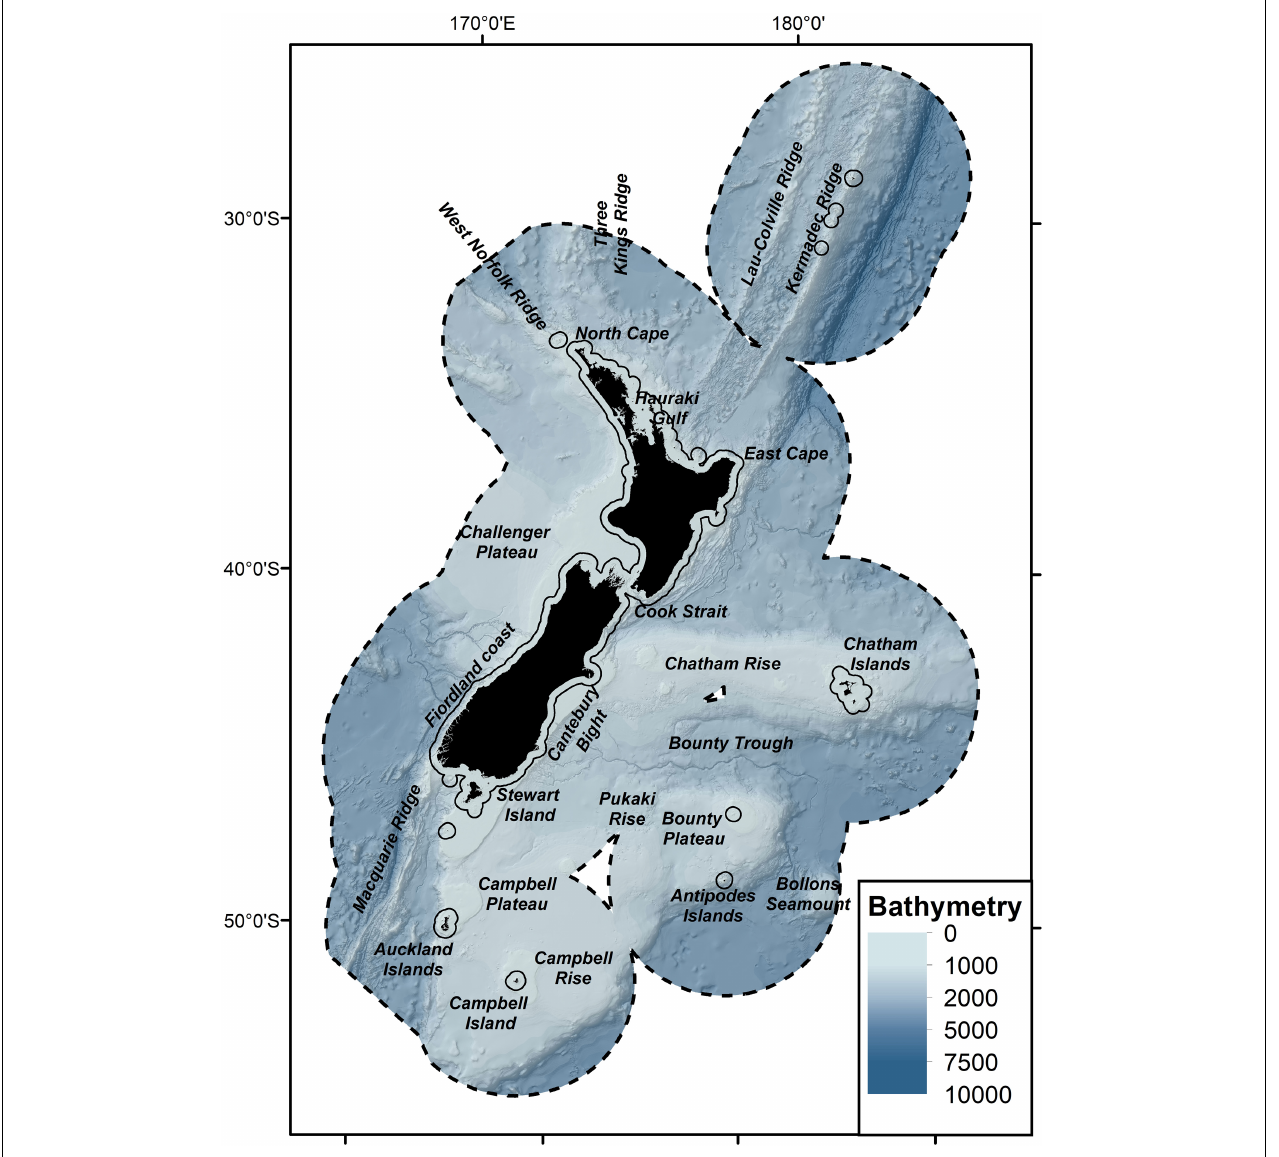
FIGURE 1 | Map of the study region. New Zealand Exclusive Economic Zone (EEZ, black dashed line), Territorial Sea (TS, solid black line), water depth and feature names used throughout the text are